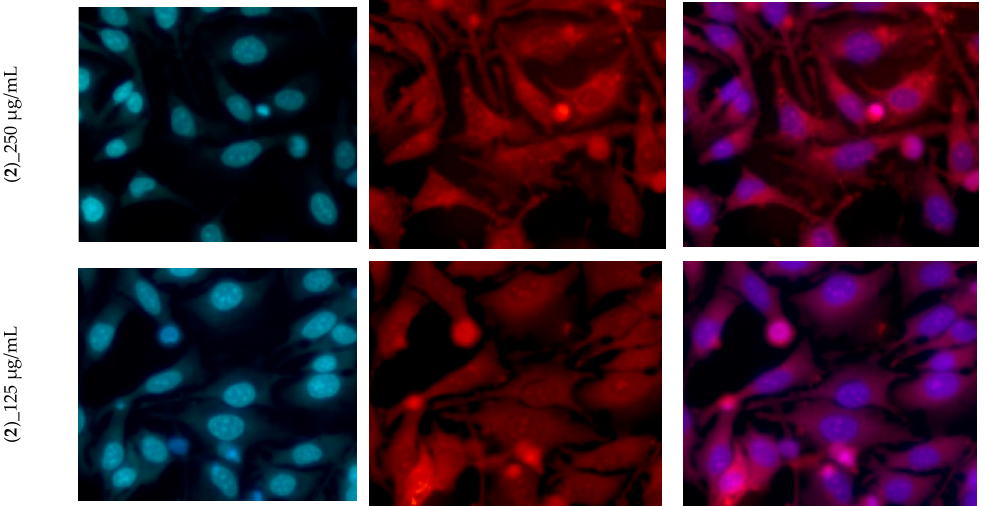
Figure 8. The morphology of Hela cells treated with different concentrations of ( 1 ) and ( 2 ).